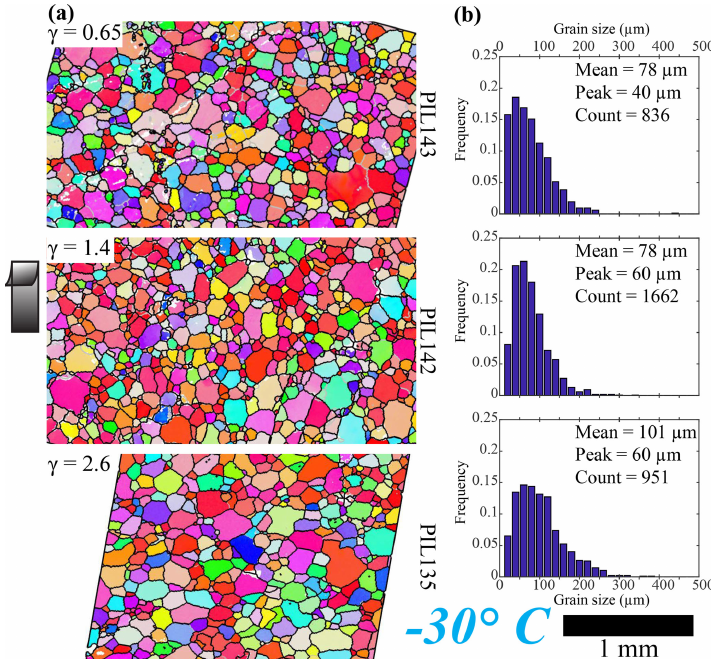
Figure 7. Microstructure of the shear planes of samples deformed at − 30 ◦ . (a) Orientation maps colored by the crystallographic direction normal to the shear plane. Color map is the same as in Fig. 5. Step size is 5µm (see Table 2, columns 5–7). Grain boundaries, characterized by a misorientation of 10 ◦ , are black, and subgrain boundaries, characterized by a misorientation of 2 ◦ , are gray. Un-indexed spots are white. The shear direction on the top side is up, as shown by the black arrow. Maps are subareas of the whole mapped area. The whole mapped area was used to calculate KAM and grain size. (b) Distributions of grain